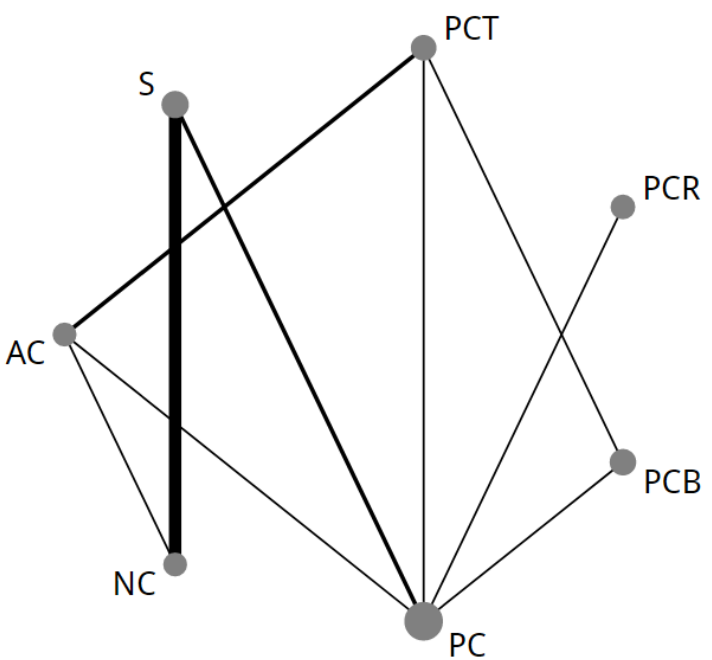
Figure 2. First network of all treatments in the strategy network meta-analysis (NMA-1). The size of each node corresponds to the number of patients who were randomly assigned to receive the given regimen. The lines connect the regimens that were directly compared in head-to-head randomized controlled trials (RCTs). The thickness of the lines corresponds to the number of RCTs. AC = adjuvant chemotherapy; NC = neoadjuvant chemotherapy; PC = perioperative chemotherapy without a taxane; PCB = perioperative chemotherapy combined with bevacizumab; PCR = perioperative chemotherapy combined with adjuvant chemoradiotherapy; PCT = taxane-based perioperative chemotherapy; S = surgery